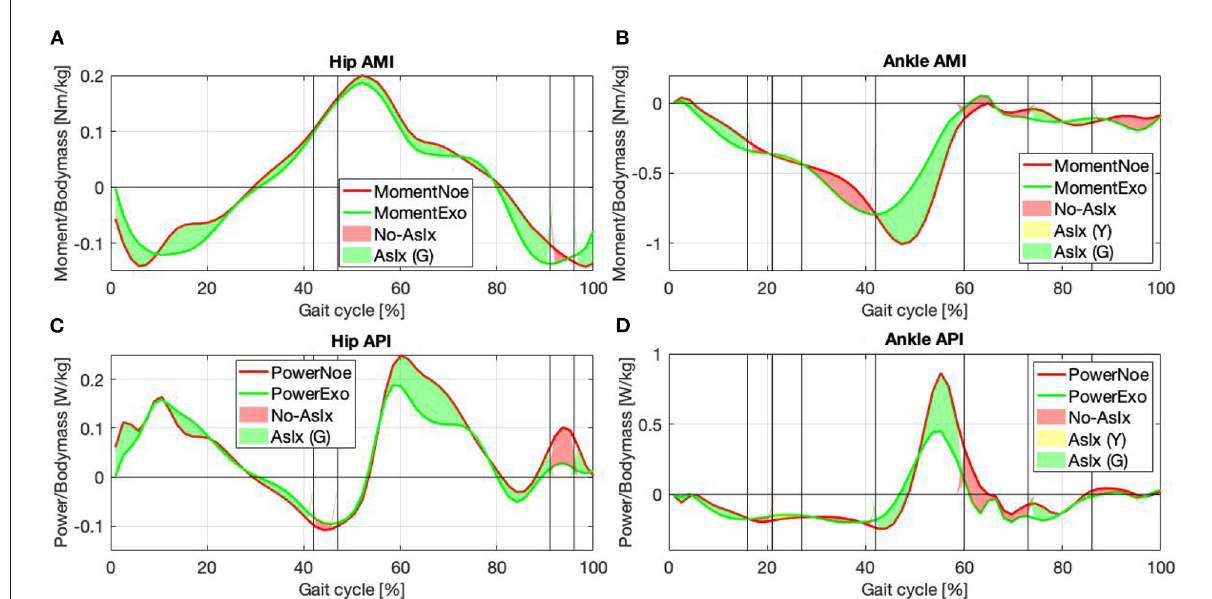
FIGURE7 Joint moment and power for the hip (A,C) and the ankle (B,D) in the Noe (red line) and Exo (green line) configuration are compared. Areas represent the instants of major (green), minor (yellow), and null (red) assistance.